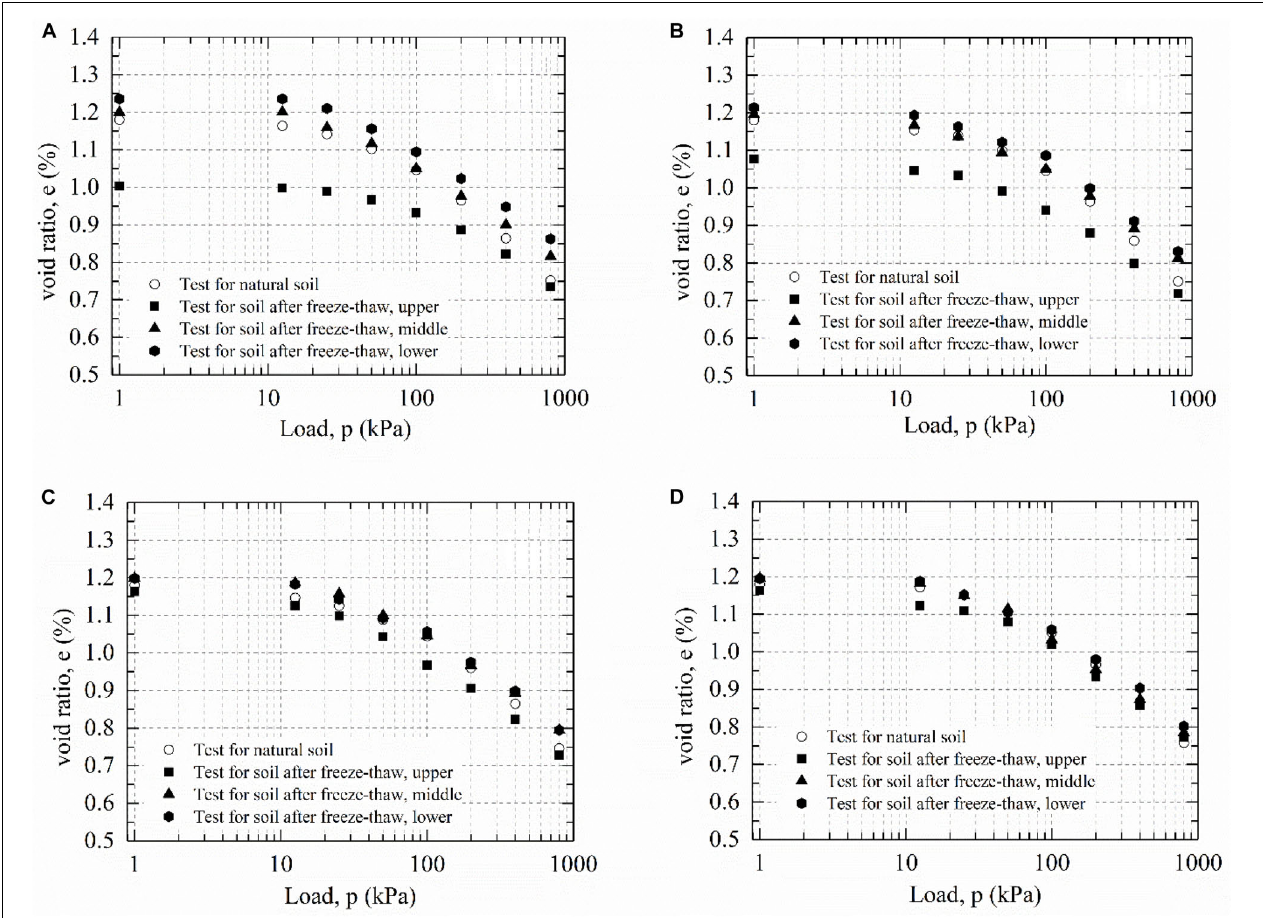
FIGURE 4 | Soil e-lg p curve before and after freeze-thaw: (A) case I, (B) case II, (C) case III, and (D) case IV.